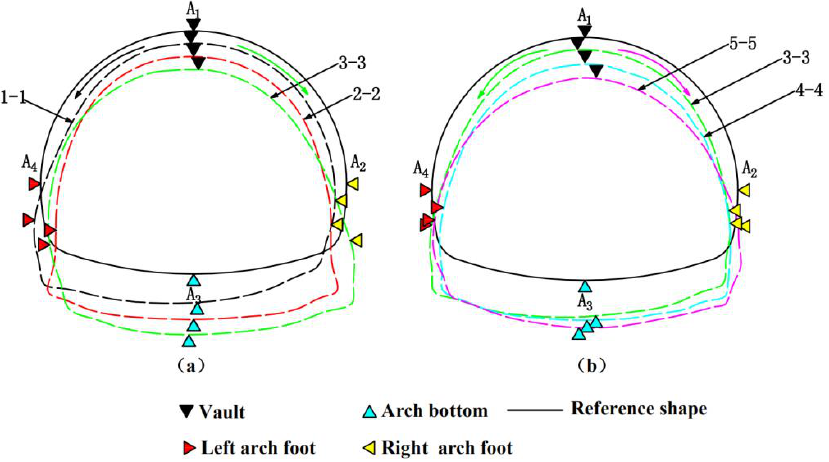
Figure 15. Rotation of each section of the existing tunnel: ( a ) after RT excavation and ( b ) after LT excavation (f = 30,000).